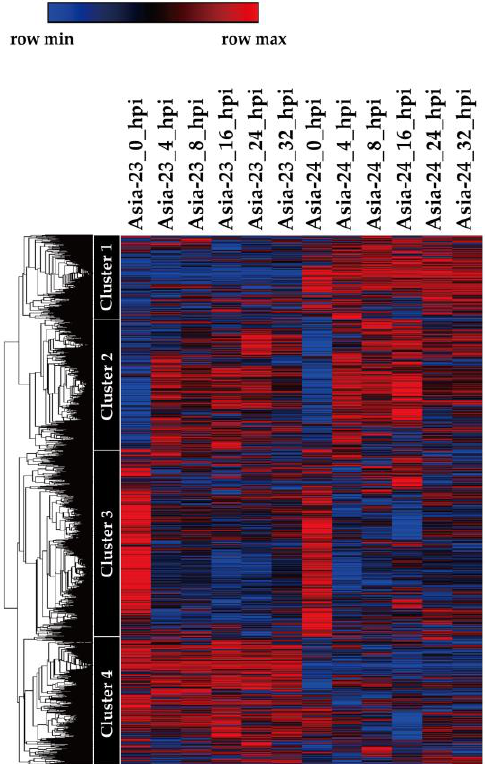
Figure 3. Hierarchical clustering analysis for time-series gene expression in Asia-23 and Asia-24. Cluster 1: Transcripts showed that the expression level in Asia-23 was lower than that in Asia-24 at all hpi points, Cluster 2: Transcripts with increased expression levels after 0 hpi in Asia-23 and Asia-24, Cluster 3: Transcripts with decreased expression levels after 0 hpi in Asia-23 and Asia-24, Cluster 4: Transcripts showed that the expression level in Asia-24 was lower than that in Asia-23 at all hpi points. The red and blue coloring indicates relatively high and low expression levels, respectively, as displayed in the scale